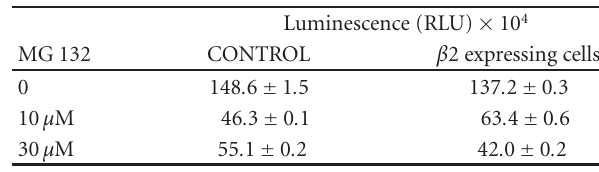
Table 2: E ff ect of MG132 on proteasome activity in